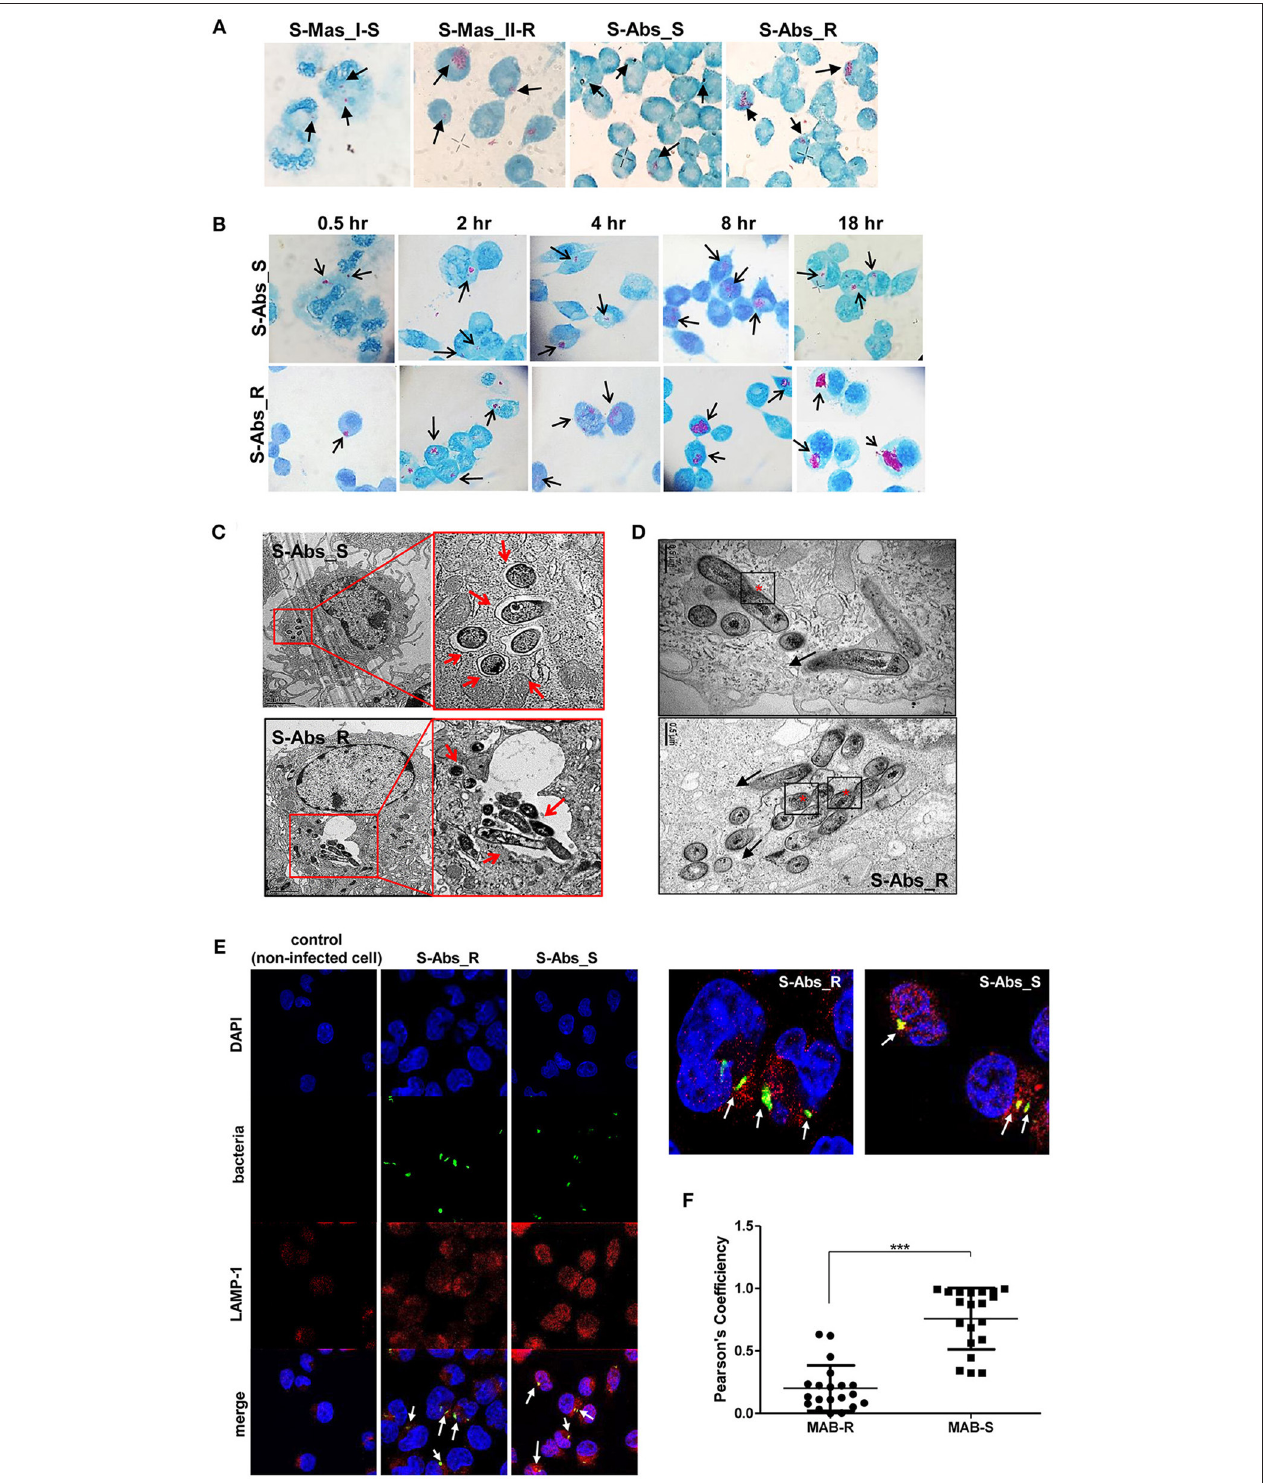
FIGURE 2 | Morphological evidence of phagosomal escape and subsequent phagosomal rupture in MAB-R-infected murine macrophage. (A) AFB stain images of macrophages infected with MAB-R strains [S-Abs_R ( M. abscessus type strain ATCC 19977 rough strain) and S-Mas_II-R (Asan 50594)] and MAB-S strains [S-Abs_S ( M. abscessus type strain ATCC 19977 smooth strain) and S-Mas_I-S (Asan 51843)] at 10M.O.I. for 24h.p.i. The black arrow indicates mycobacteria (red-stained